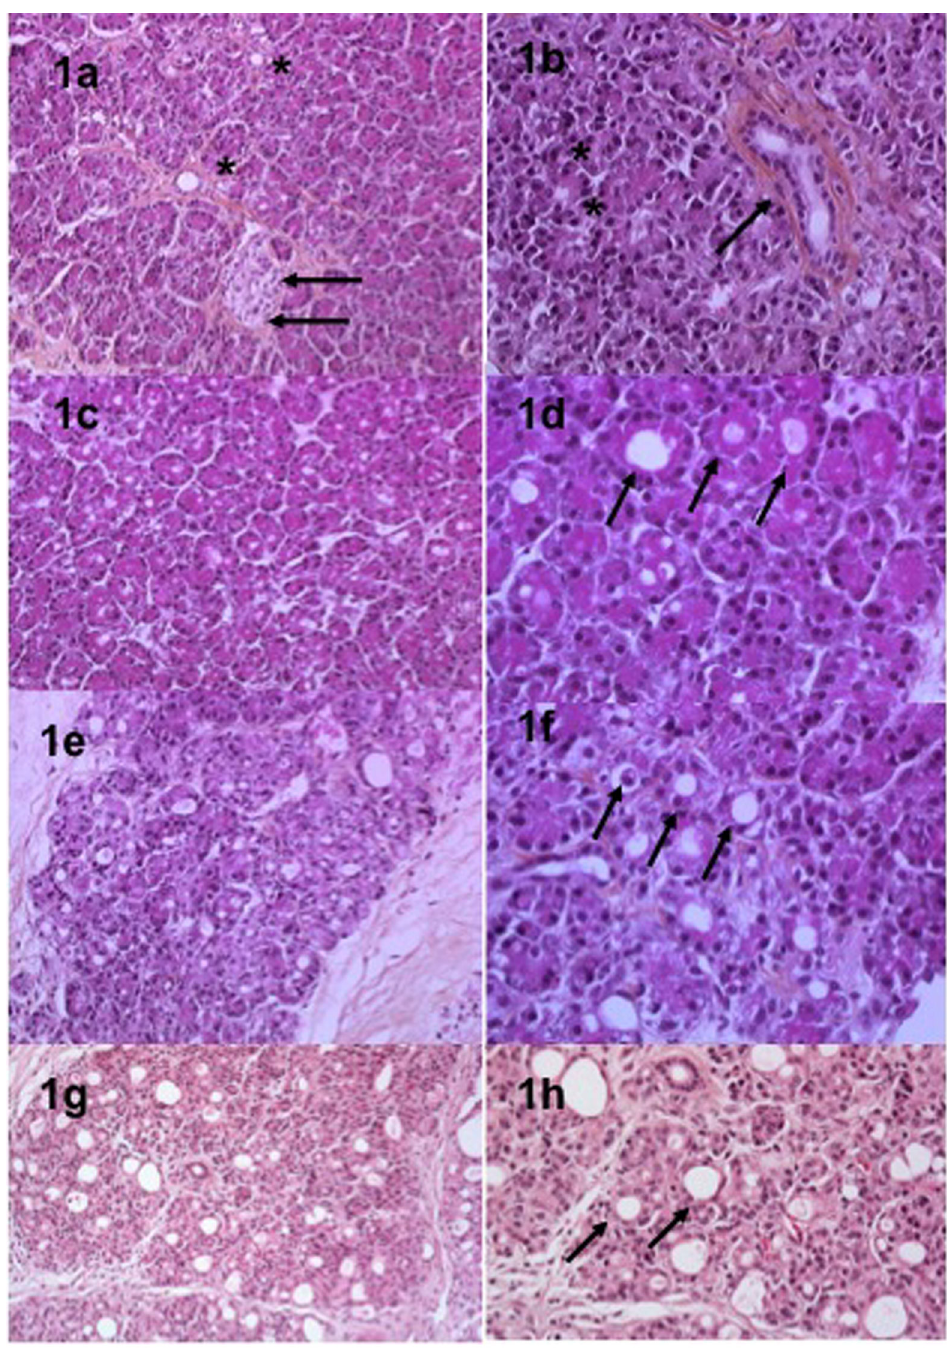
Figure 1. Microscopic examination of tissue slices at baseline (1a, 1b), H24 (1c, 1d), H48 (1e, 1f) and H72 (1g, 1h) in hyperoxic conditions. Different types of cells were observed: pancreatic ducts (black asterisks, 1a), islets (black arrows, 1a), acinar cells (black asterisks, 1b) and endothelial cells (black arrows, 1b). Acinoductal metaplasia (black arrows, 1d, 1f and 1h) was observed with a gradual appearance during the culture